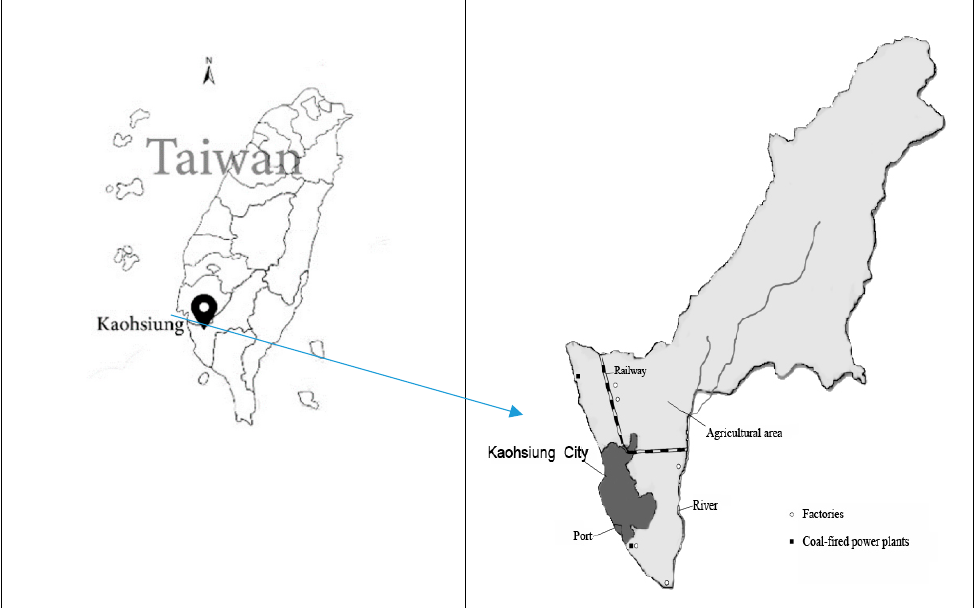
Figure 1. The location of Kaohsiung city in Taiwan.